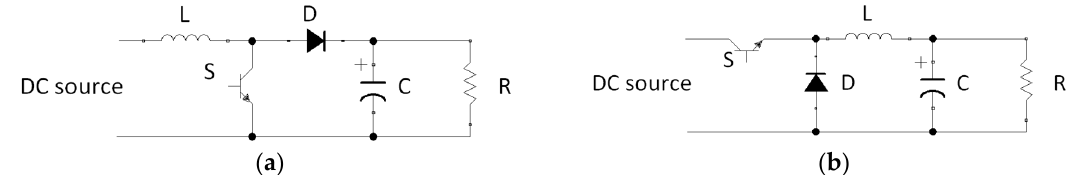
Figure 1. Conventional two-level schemes: ( a ) a boost converter, and ( b ) a buck converter. Multilevel DC–DC converters are a suitable solution to overcome the aforementioned